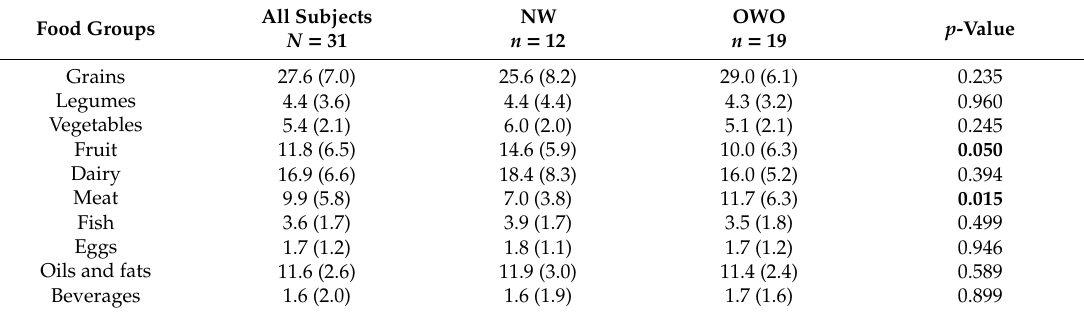
Table 3. Food group intake analysis of participants in the